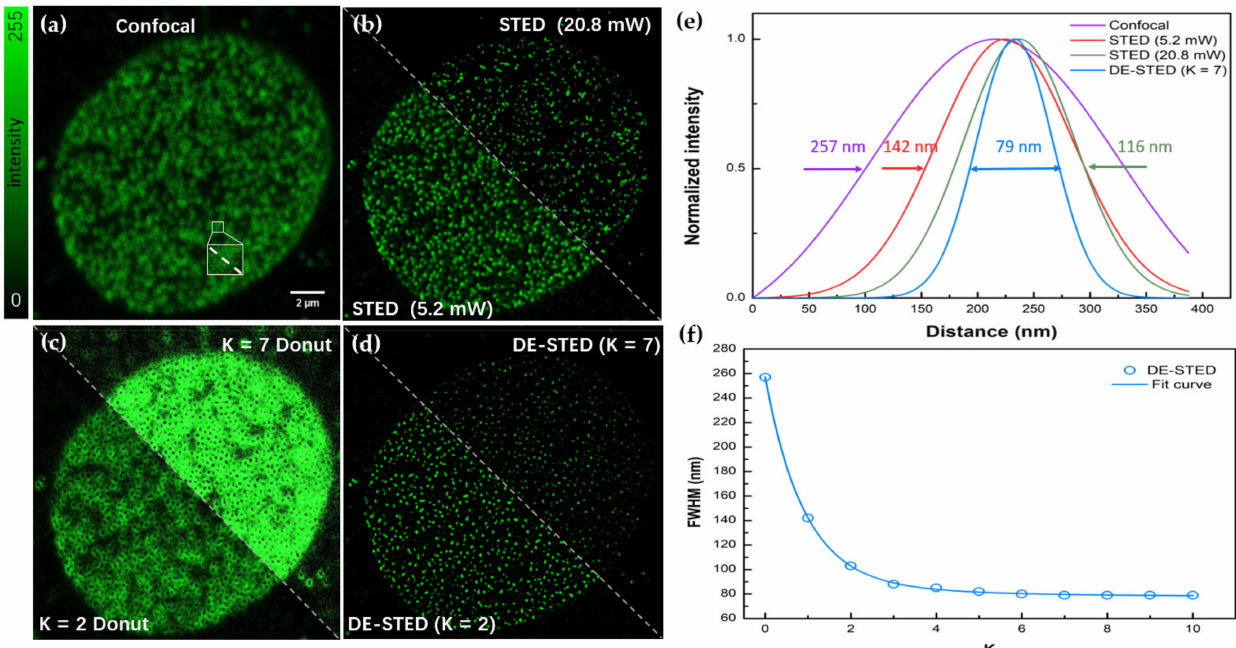
Figure 5. DE-STED imaging results for the nuclear pore complex on the lateral profile. ( a ) Confocal image. ( b ) STED image with depletion powers of 5.2 and 20.8 mW. ( c ) Donut image, where K = 2 and 7. ( d ) DE-STED results at K = 2 and 7. ( e ) The FWHM curves for confocal, STED (5.2 and 20.8 mW), and K = 7 DE-STED, taking the marked white underlined part in ( a ) as the research object. ( f ) Curves of the relationship between the FWHM and the K value. The field of view (FOV) is 20.88 µ m, Scale bar: 2 µ